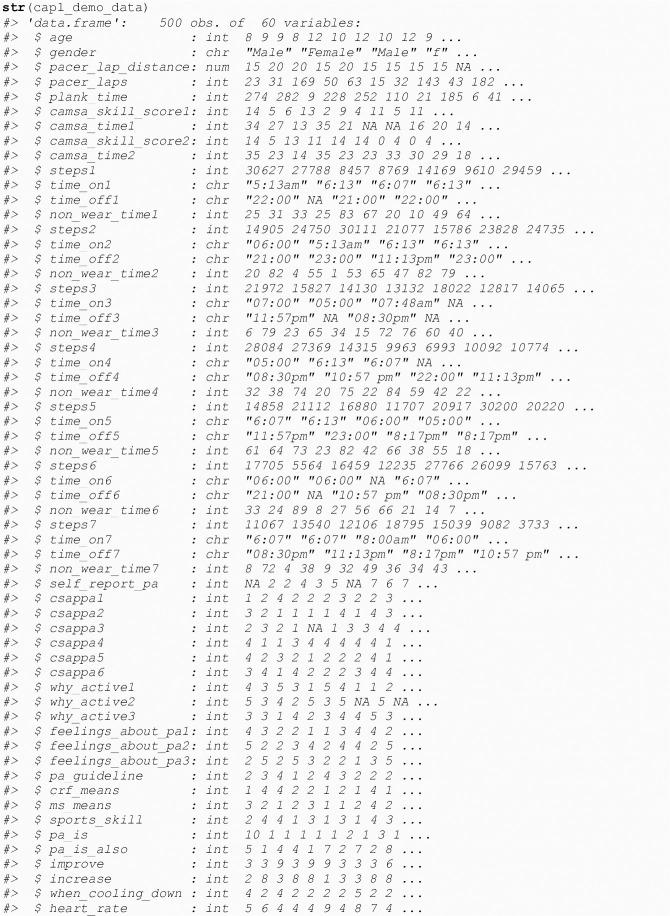
Structure of CAPL demo data.